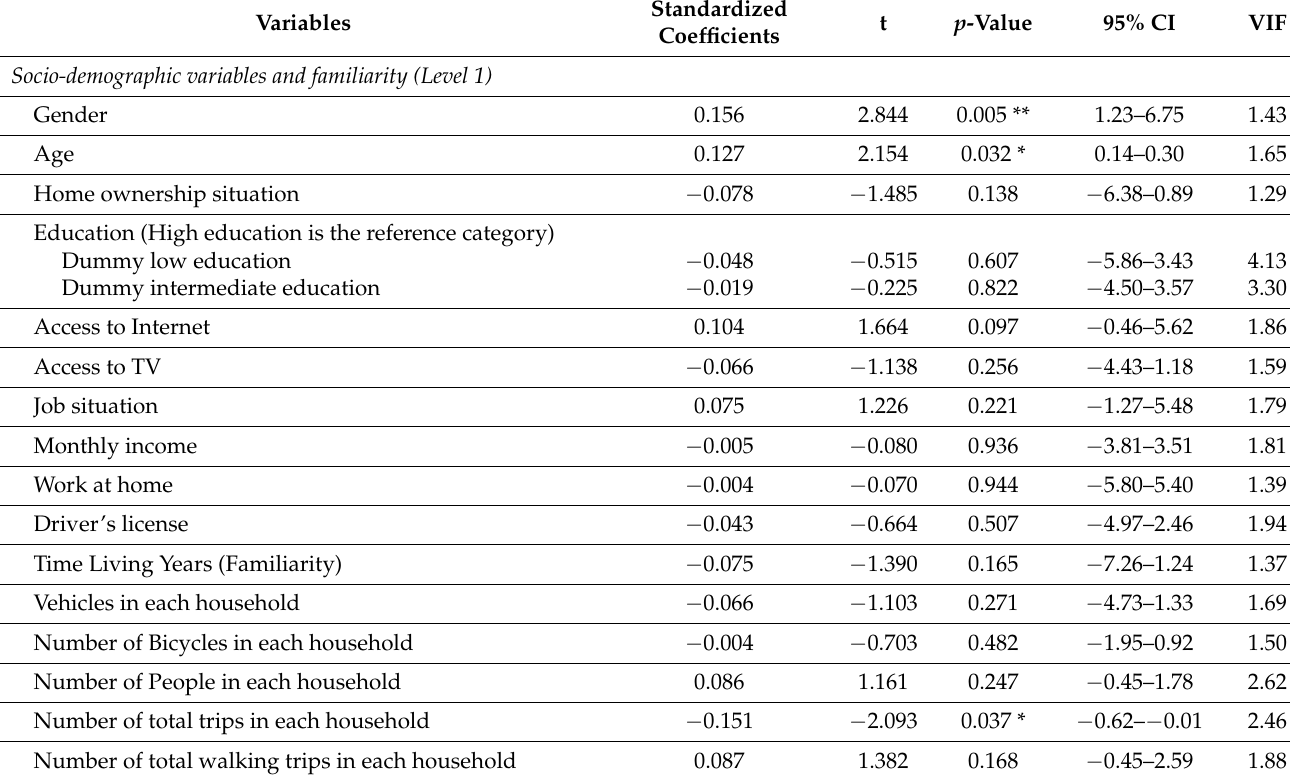
Table 3. The results of adjusted hierarchical multiple regression analysis for predicting walking behavior of older adults ( N =